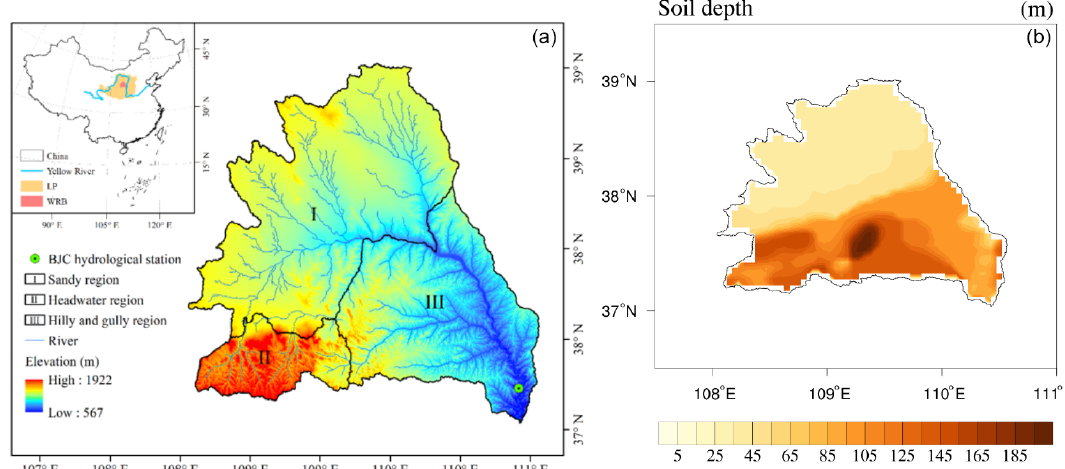
Figure 1. (a) Location of the Loess Plateau (LP) and WRB in China; (b) the geographic distribution of the observed soil depth for the WRB.